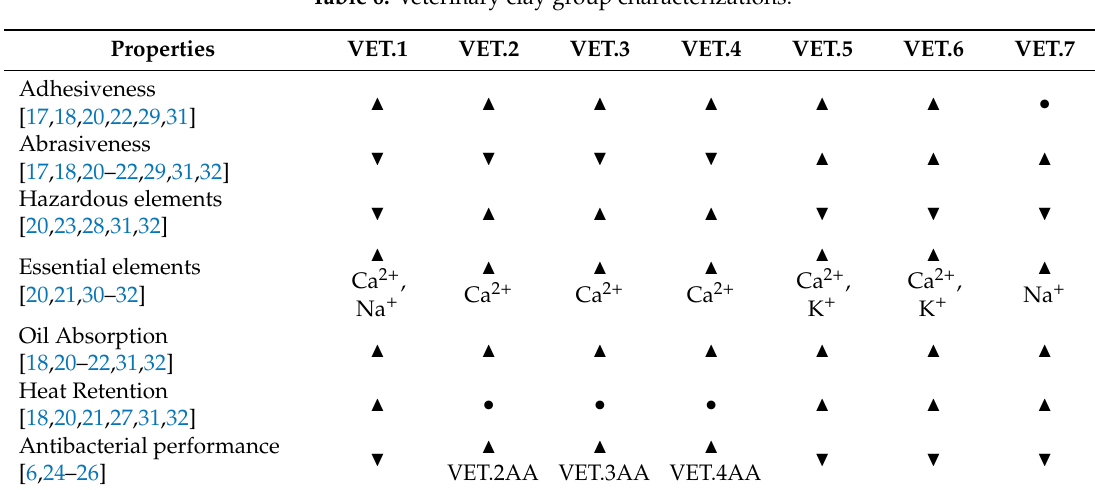
Table 6. Veterinary clay group